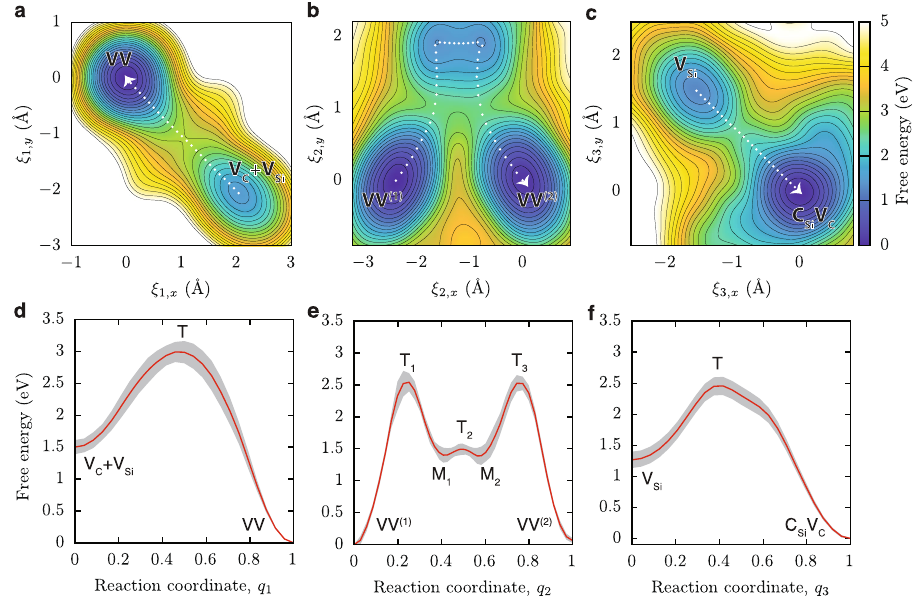
Fig. 3 Free-energy landscapes of vacancy conversion processes for VV and V Si. Potentials of mean force (PMFs) were computed using enhanced sampling simulations with FPMD. Two-dimensional order parameters, ξ i ¼ ð ξ i ; x ; ξ i ; y Þ , are used to describe the position of a carbon atom migrating toward a vacancy site, which is the primary mechanism for VV formation ( a , d ), VV reorientation ( b , e ), and V Si to C Si V C conversion processes ( c , f ). a – c 2D-PMFs show free energy surfaces of vacancy-conversion processes at 1500 K, whose minimum free-energy pathways are marked by white dotted lines. d – f Free- energy pro fi les reveal intermediate (state M i ) and transition states (state T i ) along the reaction coordinates. The gray shaded regions denote the error in the PMF determined by block averaging. All three mechanisms are thermally activated processes with relatively high-energy barriers (>1.3